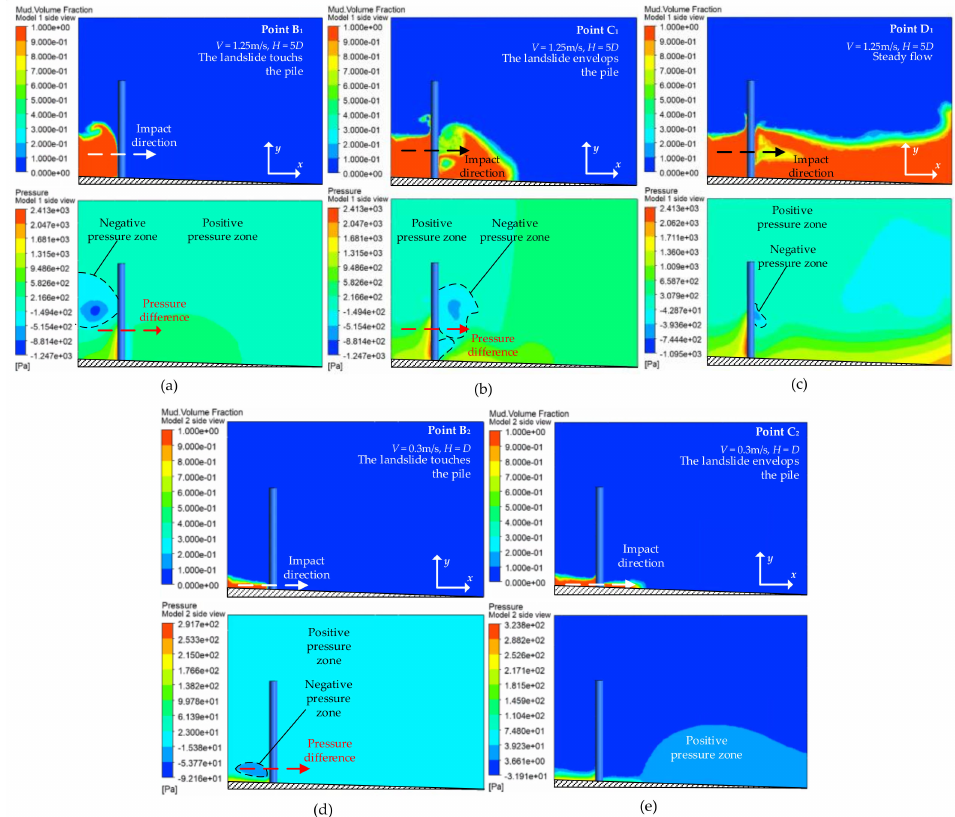
Figure 7. Submarine landslide volume fraction and pressure distribution cloud mapping. ( a ) Point B 1 in model 1. ( b ) Point C 1 in model 1. ( c ) Point D 1 in model 1. ( d ) Point B 2 in model 2. ( e ) Point C 2 in model 2.